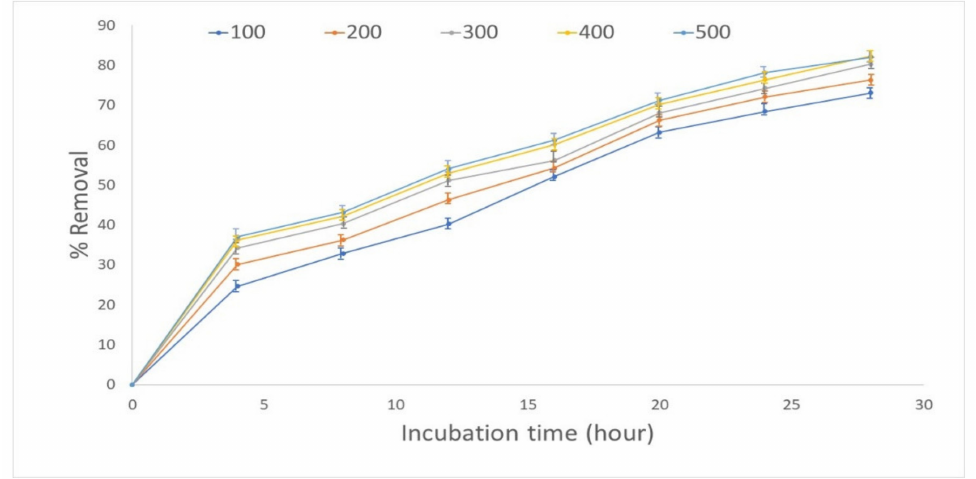
Figure 4. Effect of concentration of cobalt (II) (mg/L) on the removal of cobalt (II) by E. crassipes . pH 5.0. 28 ◦ C. 100 rpm. 1 g of natural biomass. 28 h of incubation.